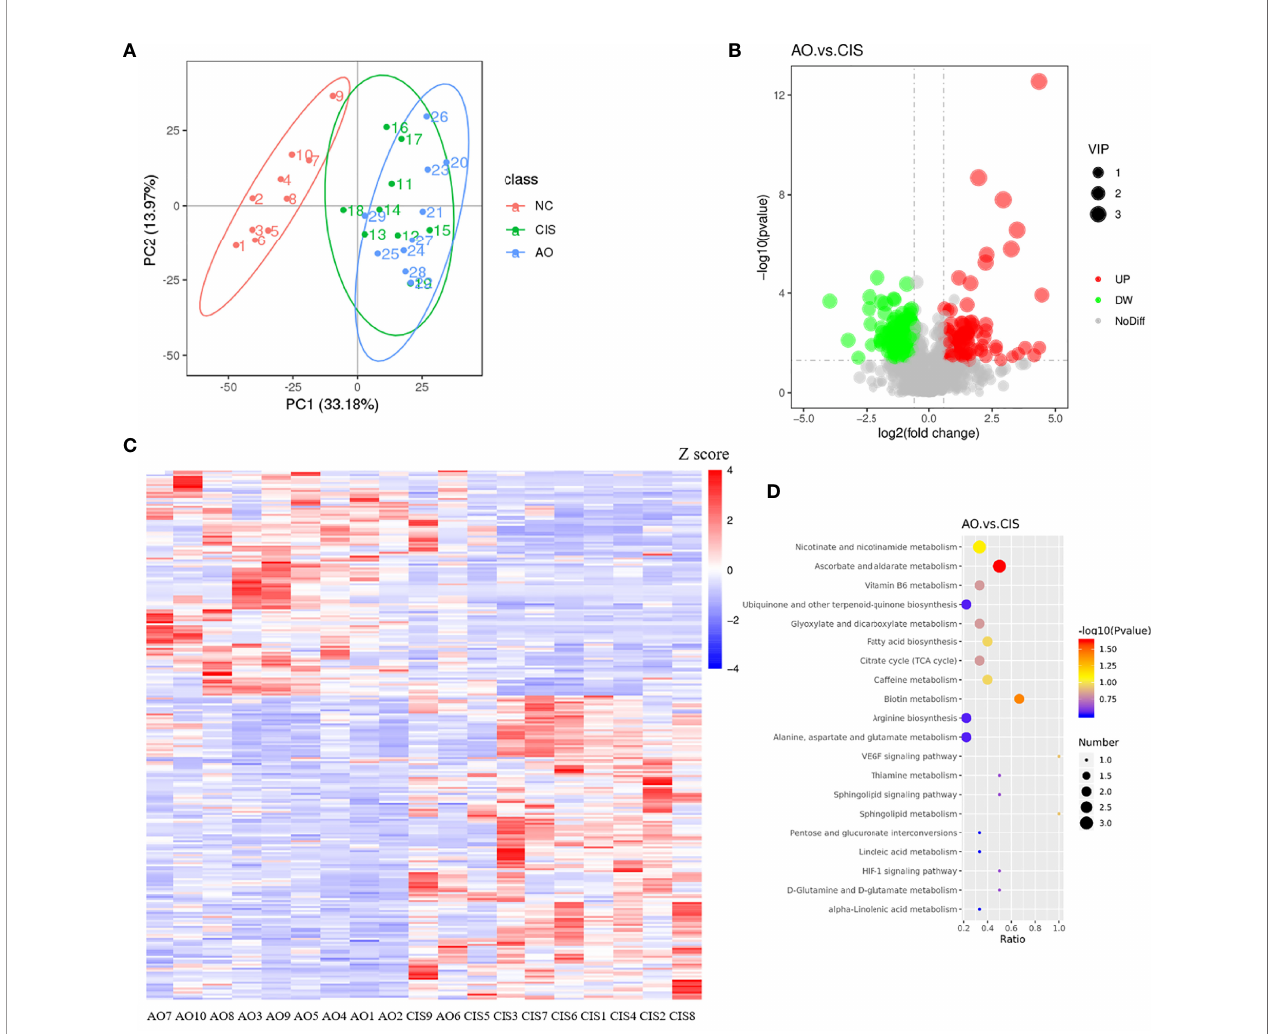
FIGURE 3 | Metabolomics analysis infeces. (A) principal components analysis (PCA)of allmetabolic pathwaysin three groups; (B) volcanomap of differential metabolites between AO group and CIS group; (C) heat map of differential metabolites between AO groupand CIS group; (D) KEGG analysis of differential metabolites between AO and CIS groups. n=10 for the AO andCIS groups, n=9 for the CIS group (one mouse inthe CIS group died whilecollecting feces).Z score valuerepresents the normalized abundance. VIP value represents correlation coef fi